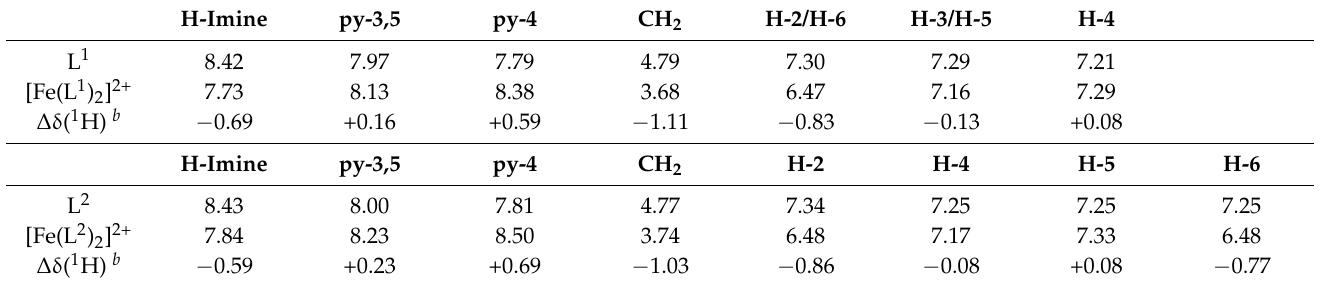
Table 1. Experimental 1 H NMR shifts (in ppm vs. TMS) in free ligands L 1 , L 2 and corresponding